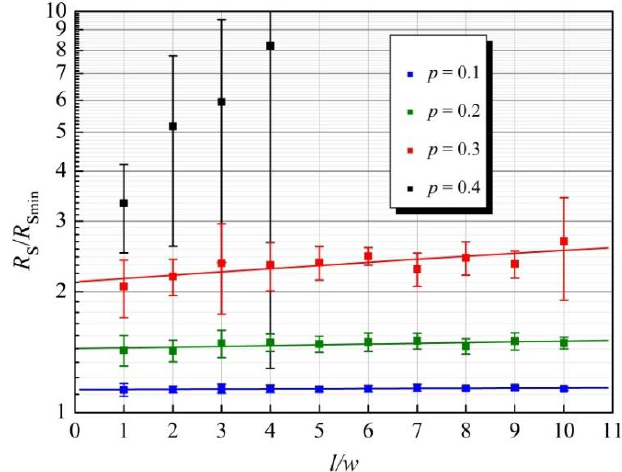
Figure 8. Calculated mean values of sheet resistance for the stripe model containing stochastically distributed defects with different concentrations p as a function of the stripe length.